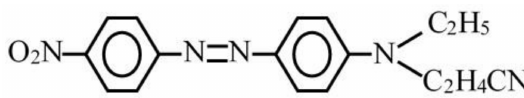
Figure 8. Molecular structures of orange dye (OD).